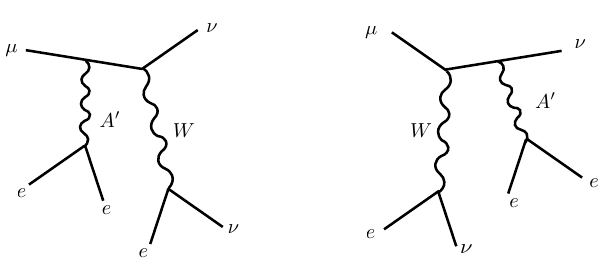
Figure 8 . Diagram contributing to the (cid:22) + A 0